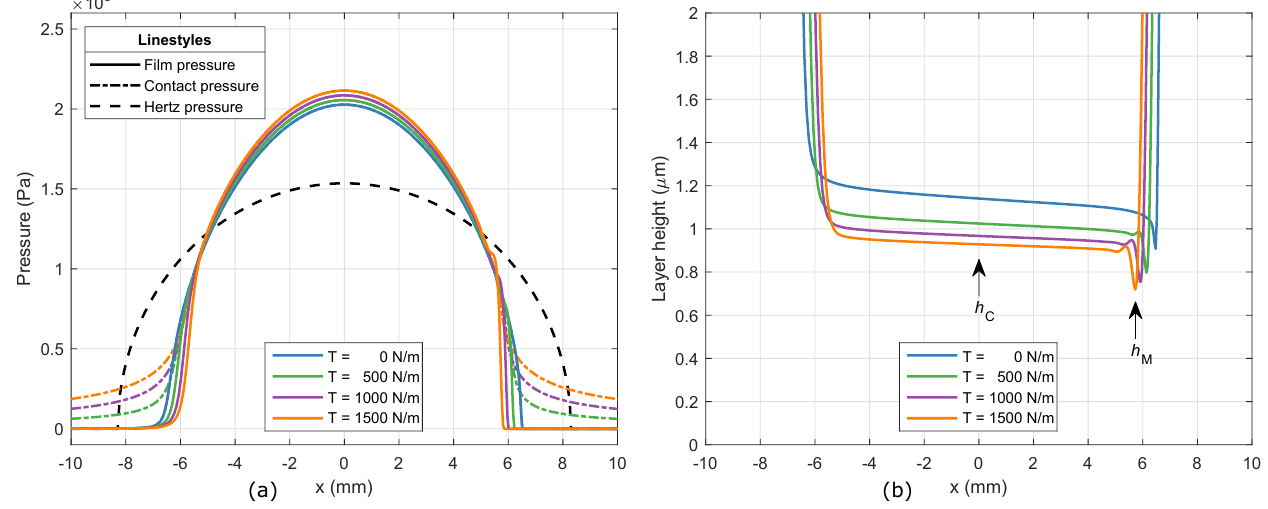
Figure 5. ( a ) The hydrodynamic film pressure ( p ) and tensioned web contact pressure ( p C ) along the x -coordinate for varying web tension values. The Hertz dry contact pressure profile from Equation (15) is shown for reference. ( b ) The layer height ( h ) along the x -coordinate for varying web tension